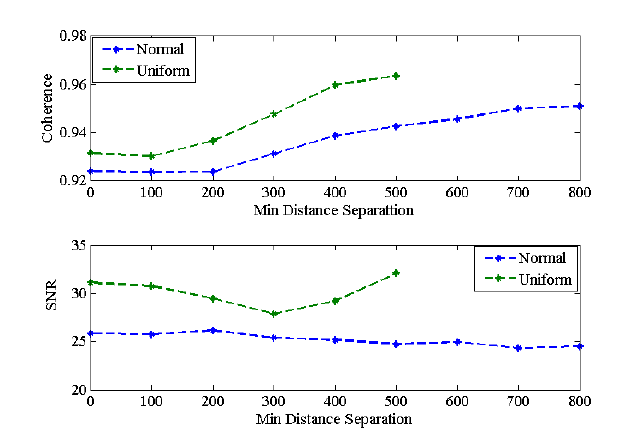
Figure 9. Impact of minimum distance separation on coherence, average received SNR and No of